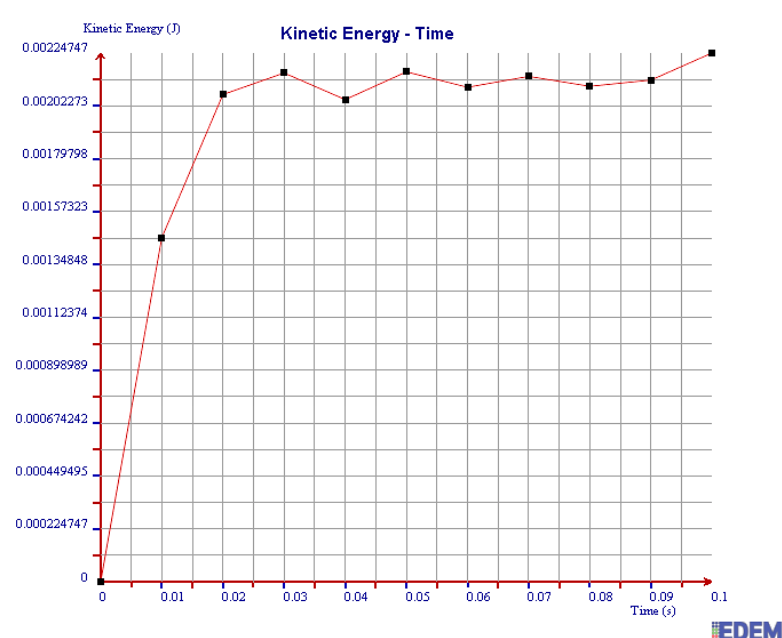
Figure 22. Kinetic energy of 2 mm chromium balls.